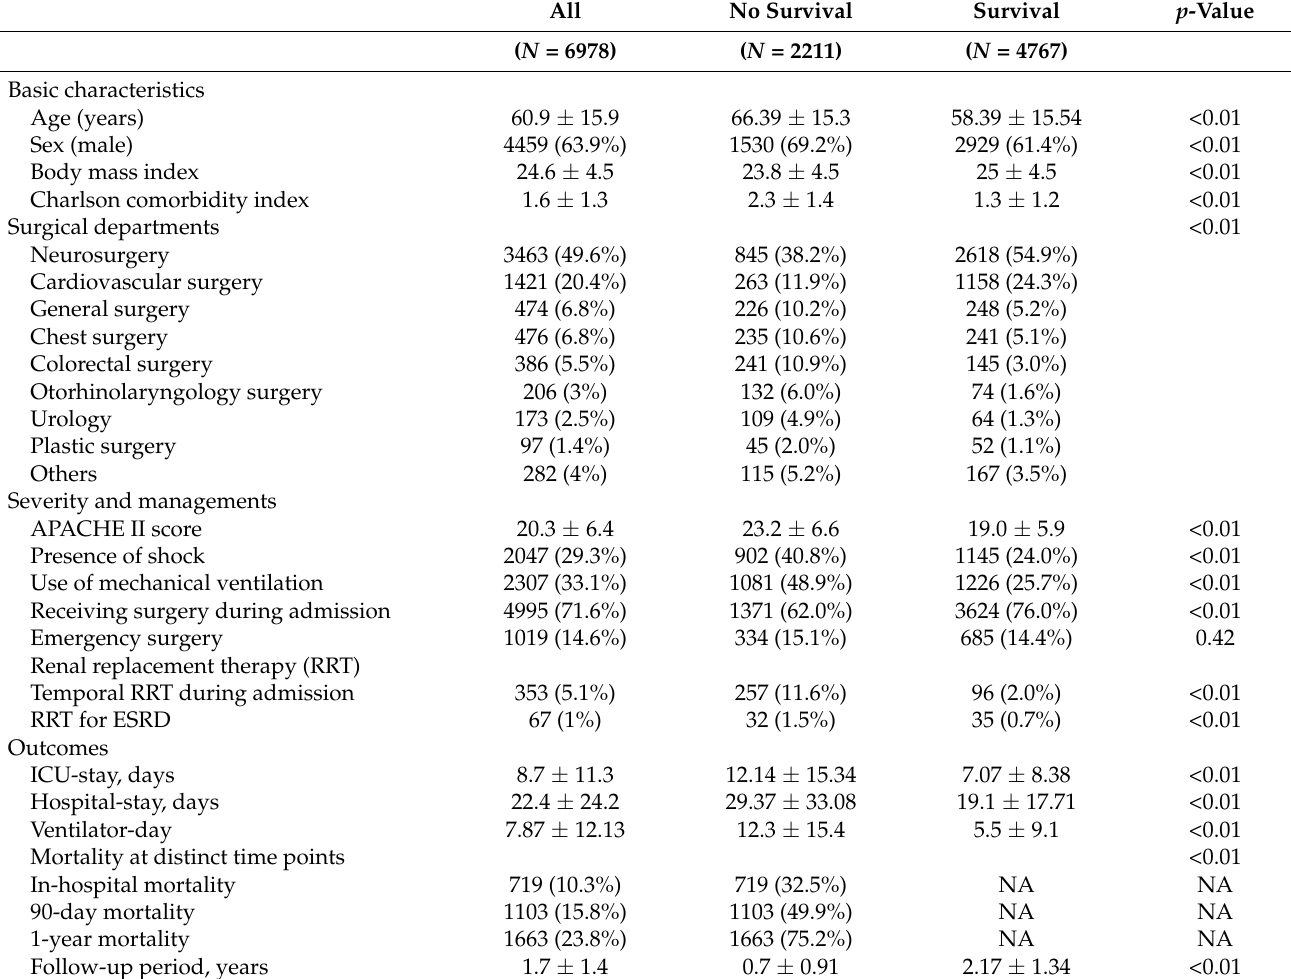
Table 1. Characteristics of enrolled critically ill surgical patients categorised by overall